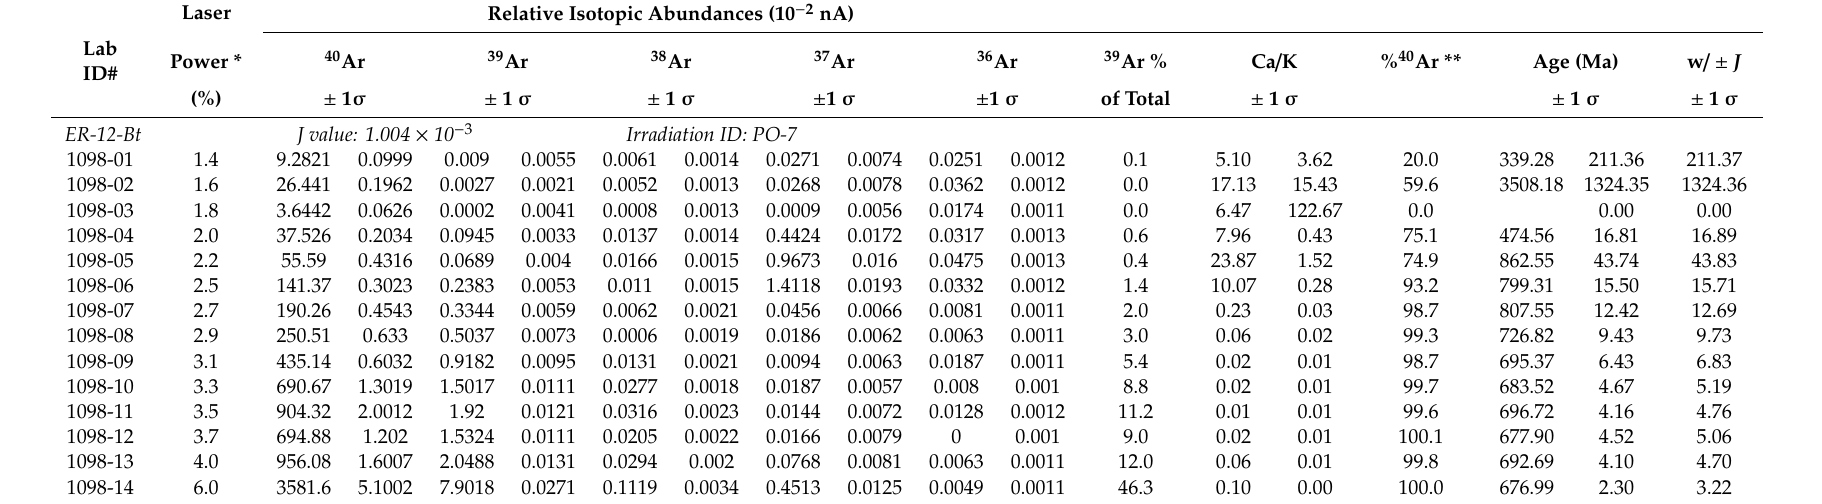
Table 7. Results and measurements conditions of 40 Ar / 39 Ar analyses of Vinoren